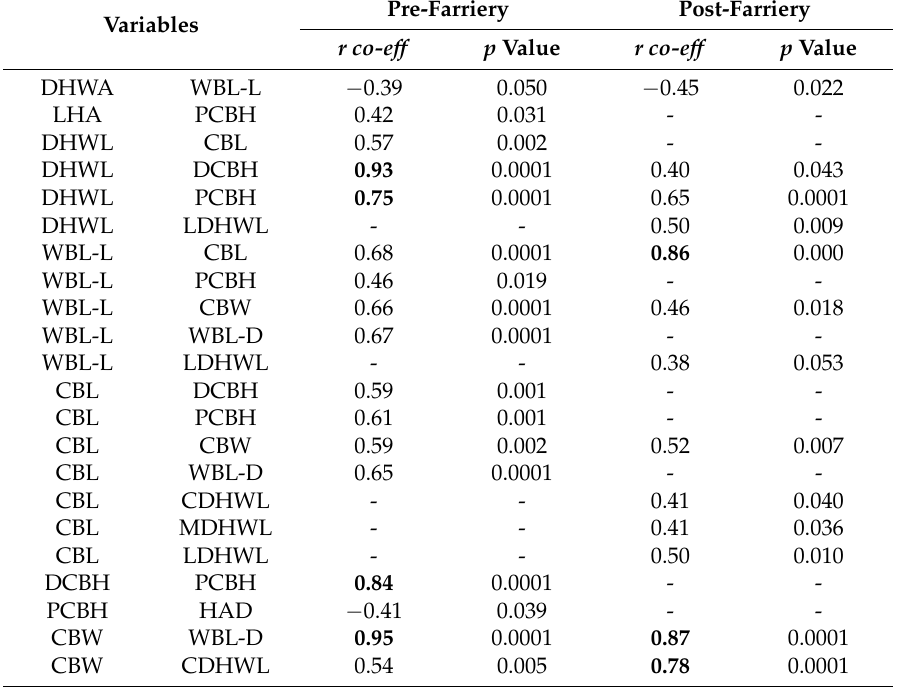
Table 6. Significantly correlated variables pre- and post-farriery. Bold regression co-efficient values denote strong (>0.75) relationships.